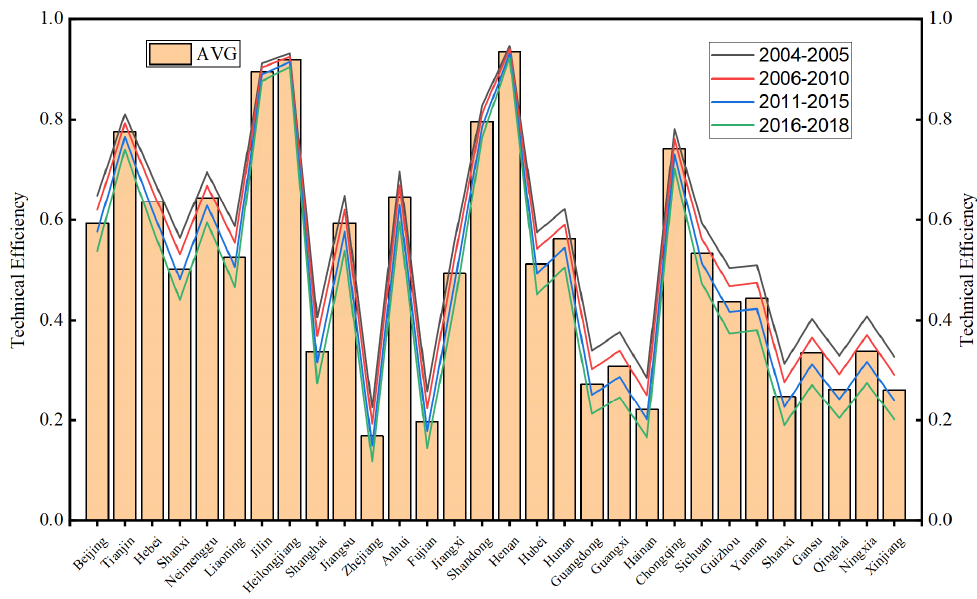
Figure 4. Technical efficiency and average level in four different periods.